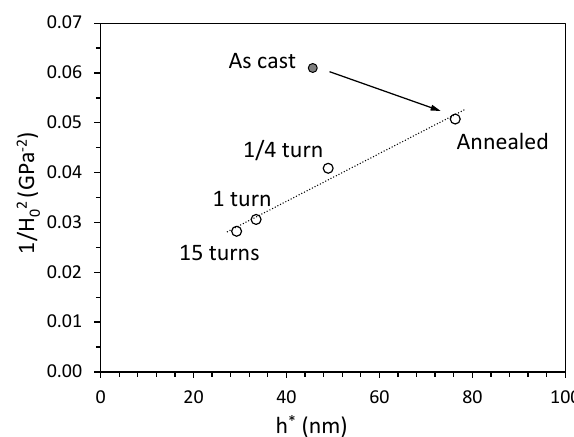
Figure 4. Characteristic depth dependence of the hardness in the limit of infinite depth for as cast sam- ple, annealed sample and samples HPT strained from 1/4 turn to 15 turns.